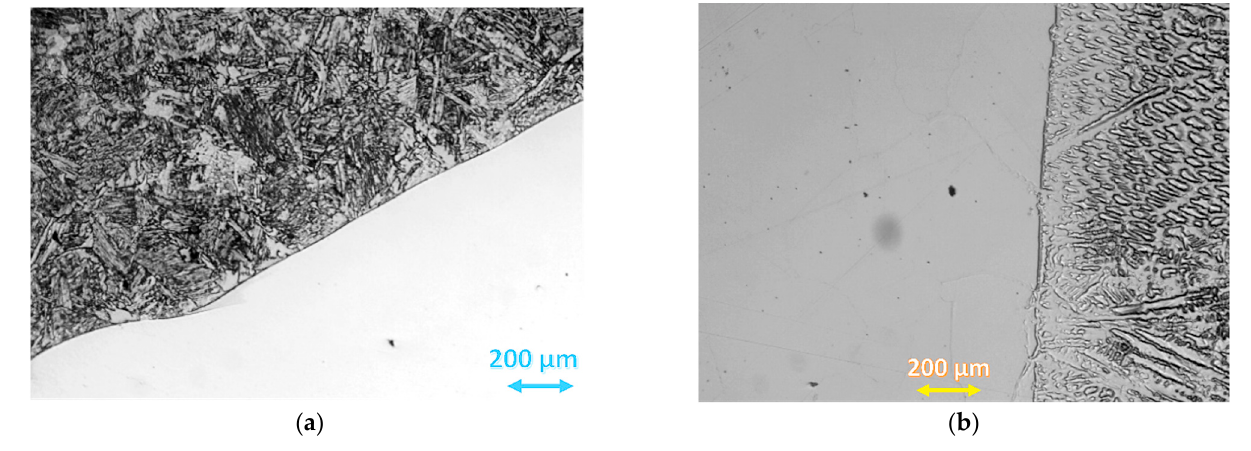
Figure 9. Mixed joint fusion line: ( a ) fusion line from the S355J2W+N steel side, ( b ): fusion line from the Alloy 59 side.